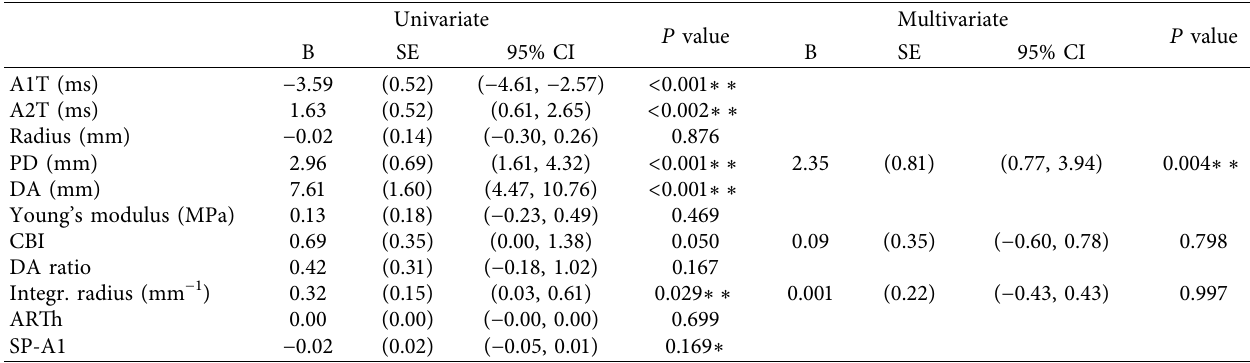
Supplementary Table S1: correlations between variables ( N � 197). ( Supplementary Materials